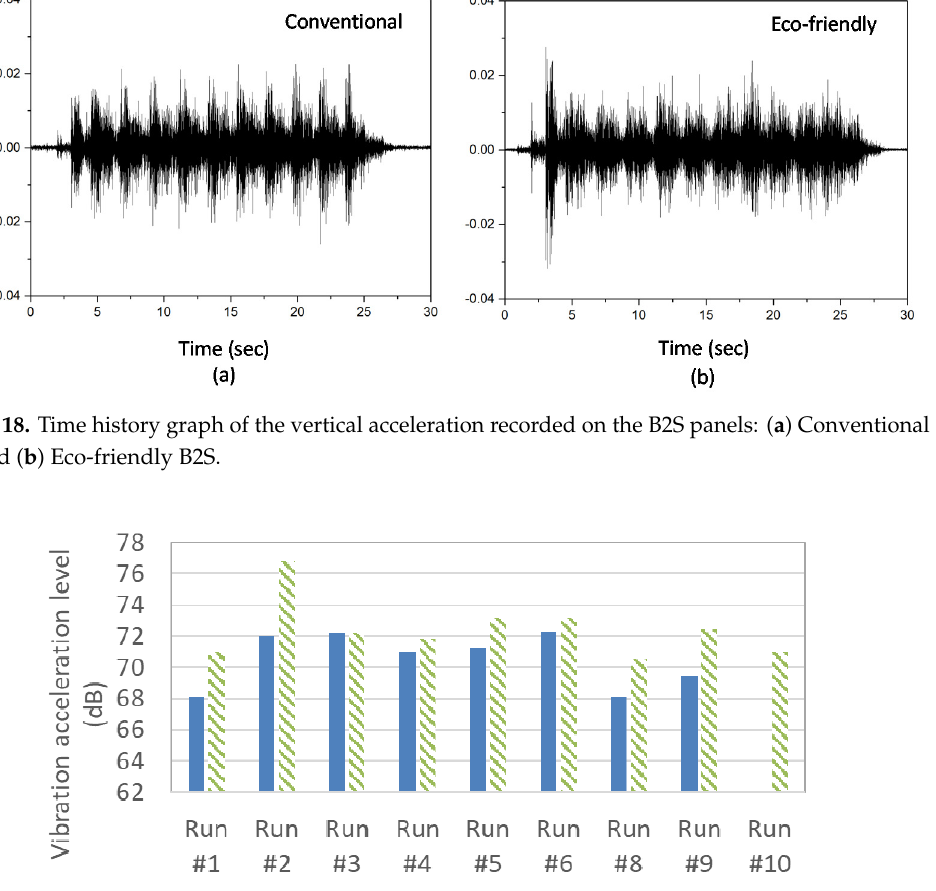
Figure 17. Lateral accelerations on the tunnel wall with respect to speed.